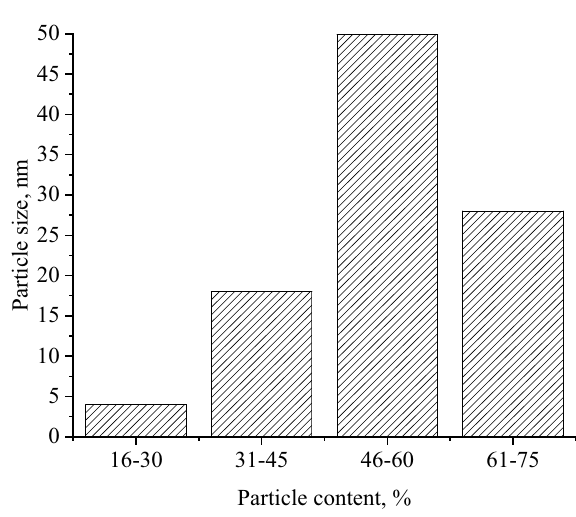
Figure 2. Histogram of the size distribution of Se NPs stabilized with